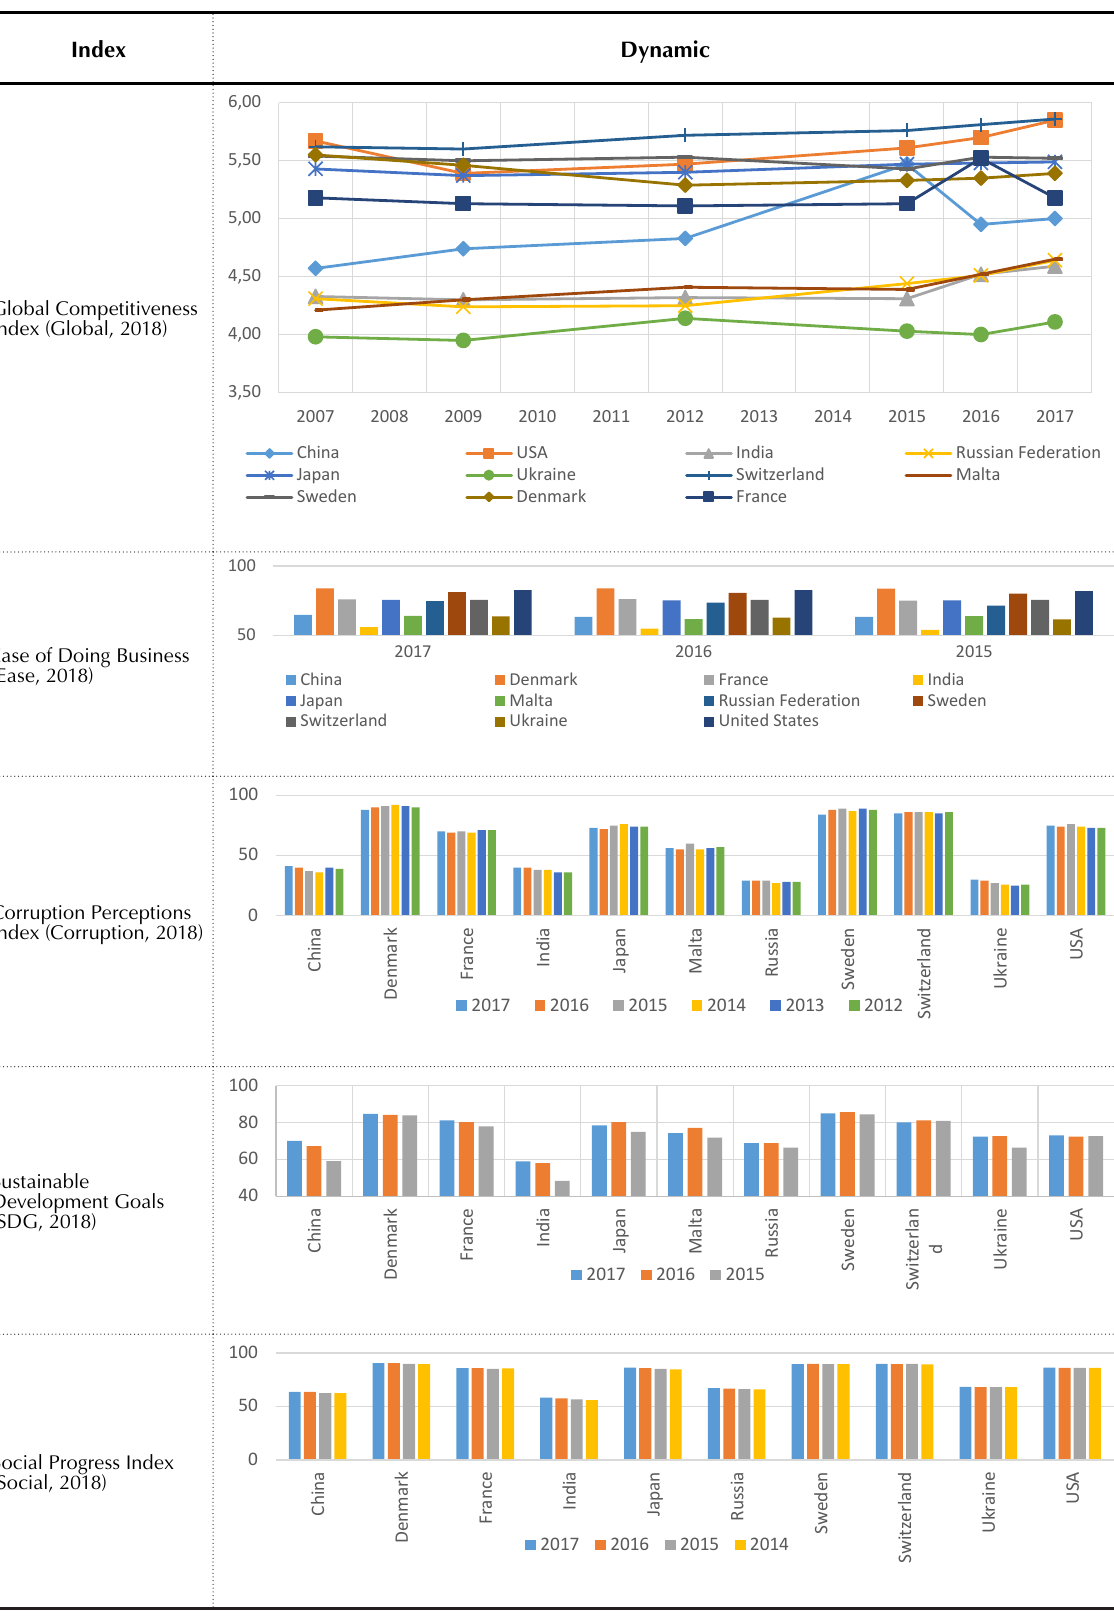
Table 1. The main world economic, ecological and social